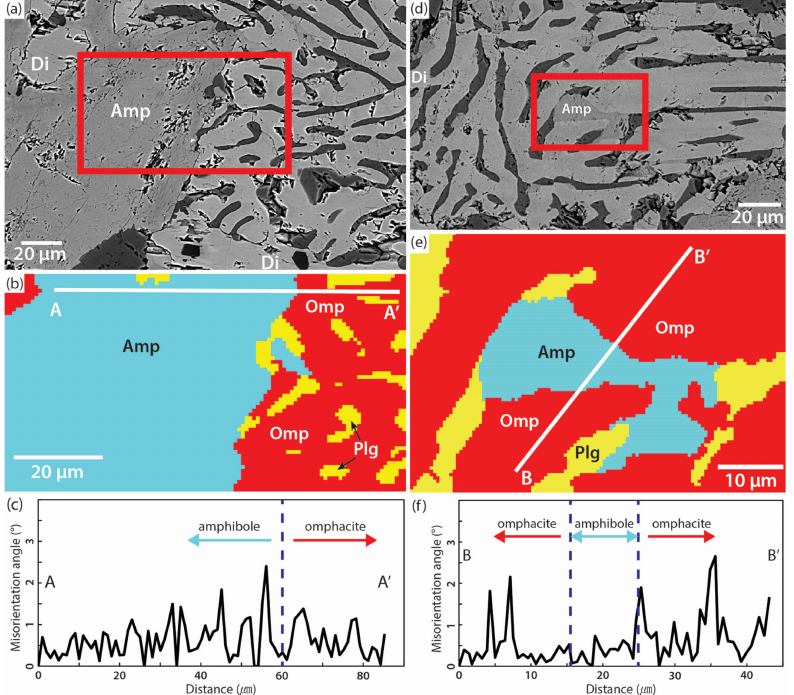
Figure 7. ( a ) and ( d ) Back-scattered electron image of amphibole and directly contacting omphacite symplectite in sample 885; ( b ) and ( e ) EBSD phase map of the area located in the red rectangle in ( a ) and ( d ); and ( c ) and ( f ) misorientation angle distribution spectra along A–A (cid:48) in ( b ) and B–B (cid:48) in ( e ). Vertical dashed lines indicate the phase boundary between amphibole and omphacite. Omp: omphacite; Amp: amphibole; Di: diopside; Plg: